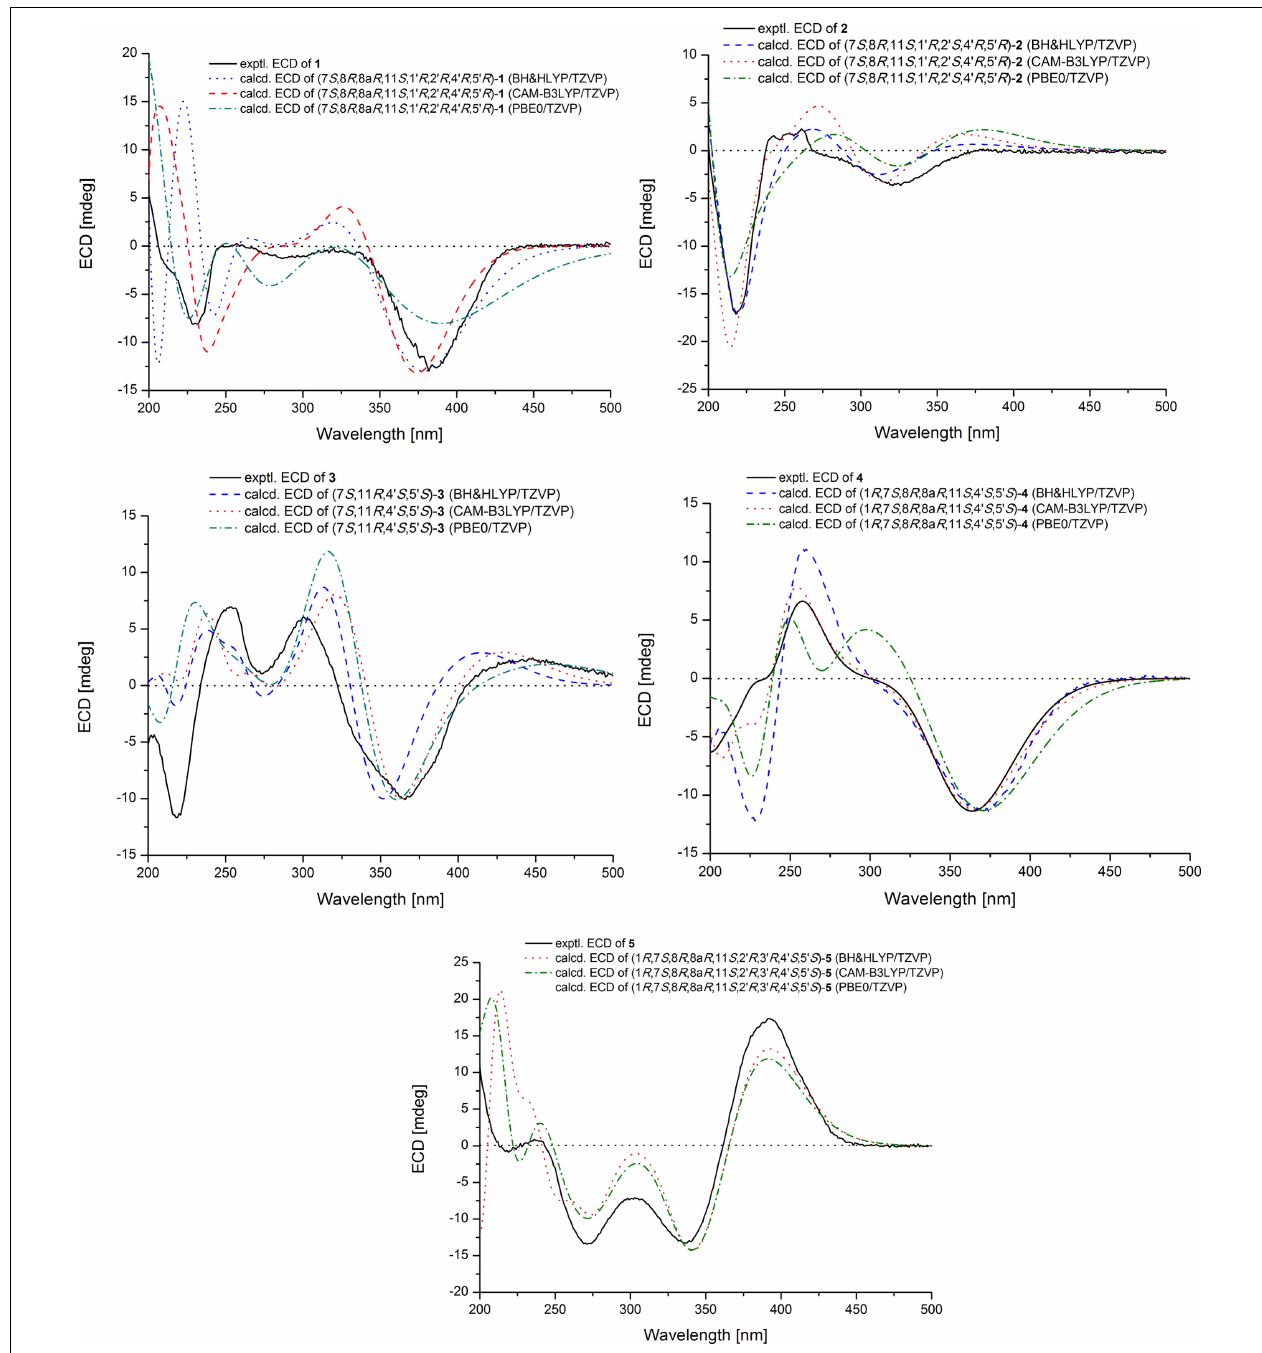
FIGURE 4 | Experimental and calculated ECD spectrum of 1–5.